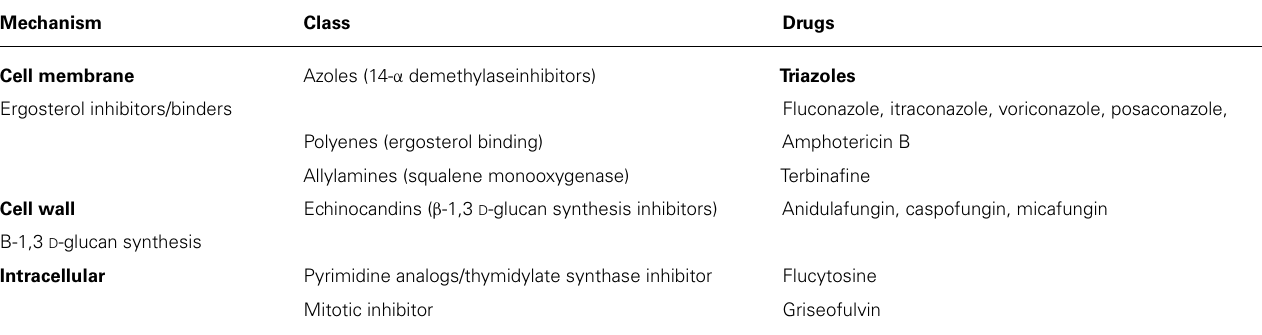
Table 1 | Commonly used systemic antifungal drugs [as reviewed by Lewis